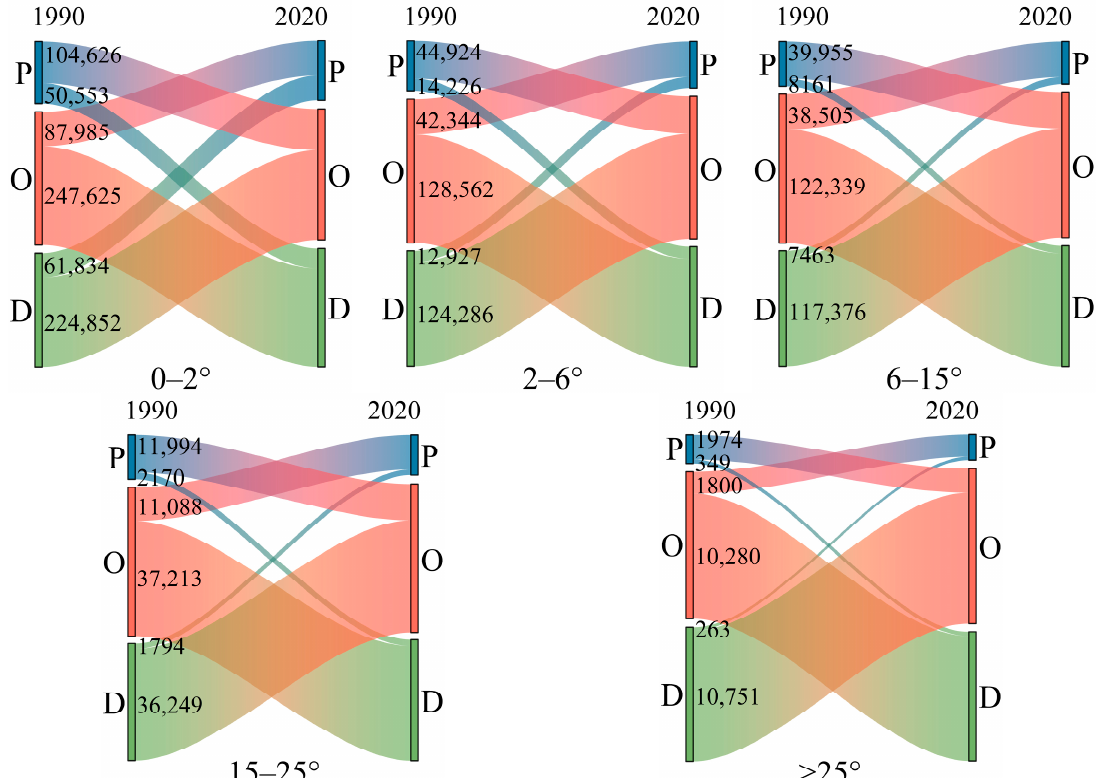
Figure 7. Land conversion between paddy field, dryland, and other land at different slopes from 1990 to 2020.